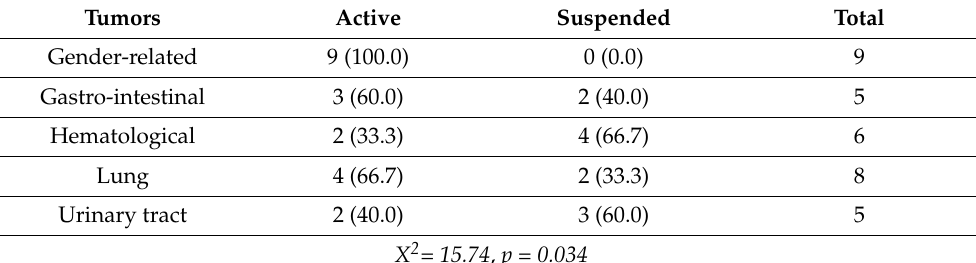
Table 4. Numbers of registered trials in 2021 according to status and diagnosis. Tumors Active